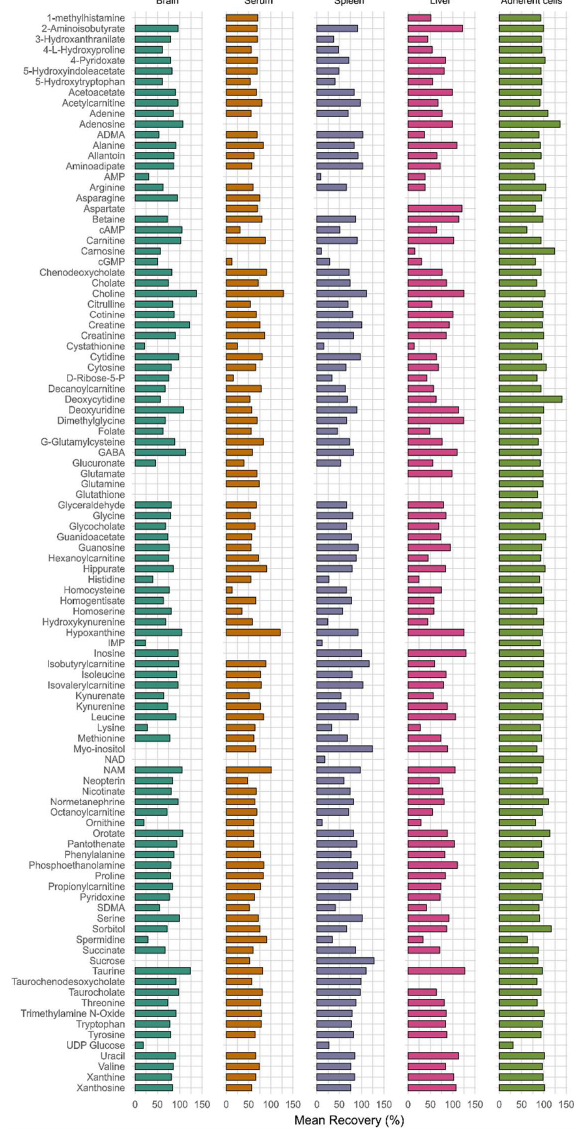
Figure 3. Percentage mean recoveries for all metabolites at low, medium, and high concentration levels of QCs (N = 6 at each level) spiked in serum, brain, spleen, liver, and adherent cells. Data not shown for metabolites with poor chromatography and irreproducible results at different concentration levels.